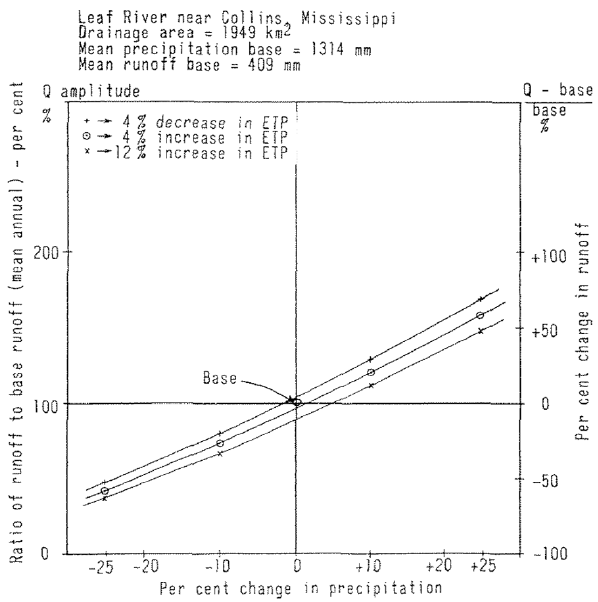
Figure 2. Yield change graph proposed by Nemec and Schaake (1982) to illustrate the hydrological elasticity